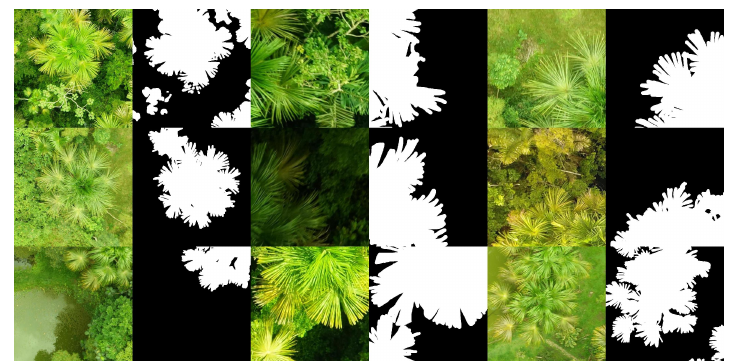
Figure 4. Samples of original images and shadow masks from the MauFlex dataset.